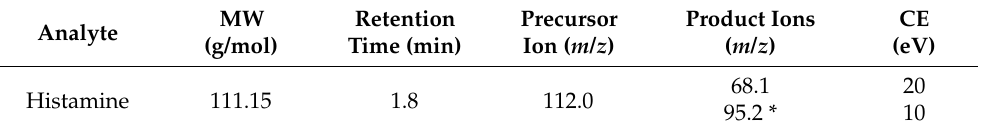
Table 1. Mass spectrometric parameters for the determination of histamine using an electrospray interface (ESI) in positive ionization mode. Analyte